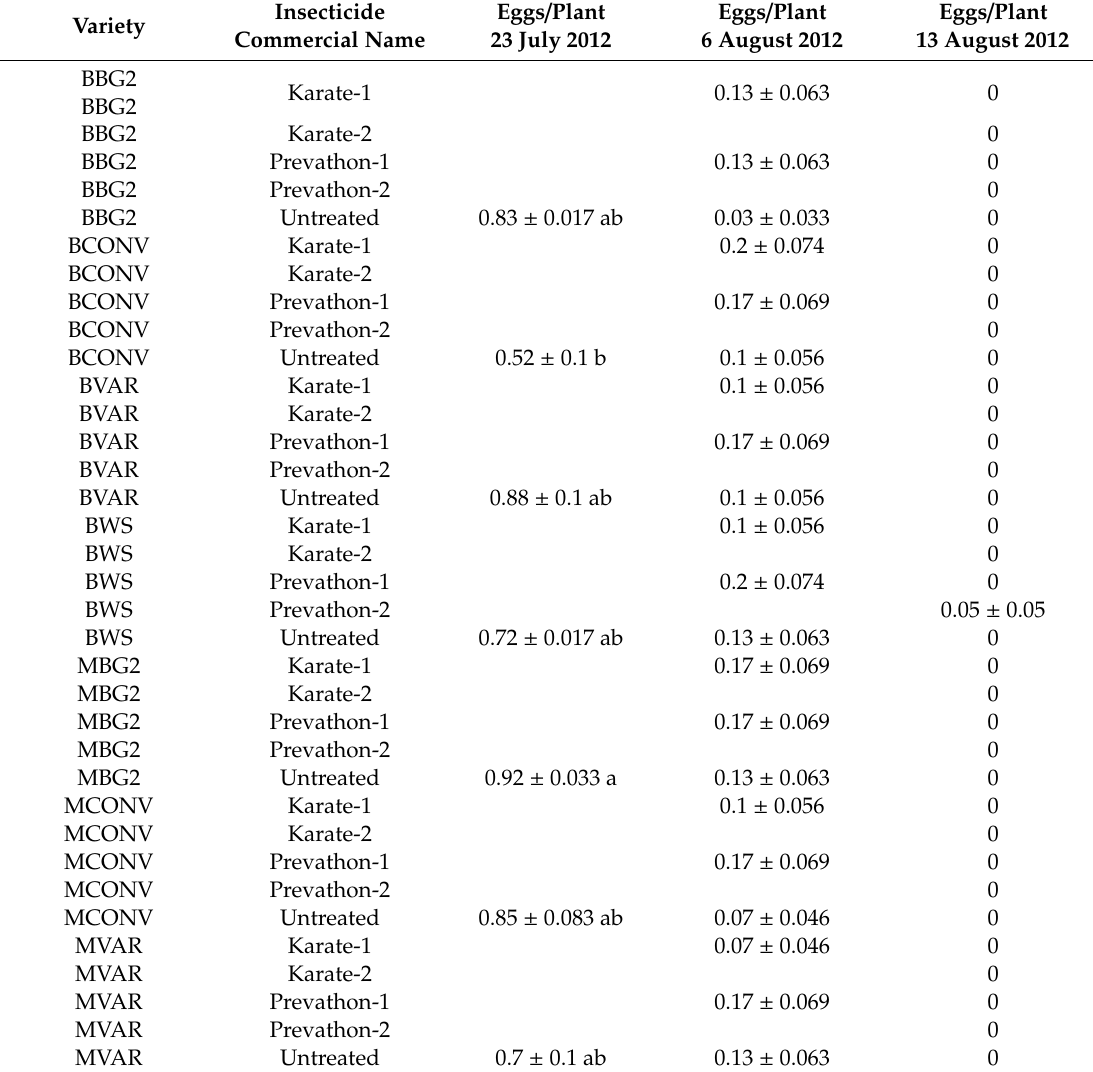
Table 3. Mean egg densities ± SEM observed in cage study plots in 2012. Means not followed by a common letter indicate significant di ff erences between treatments based on LSD at p <